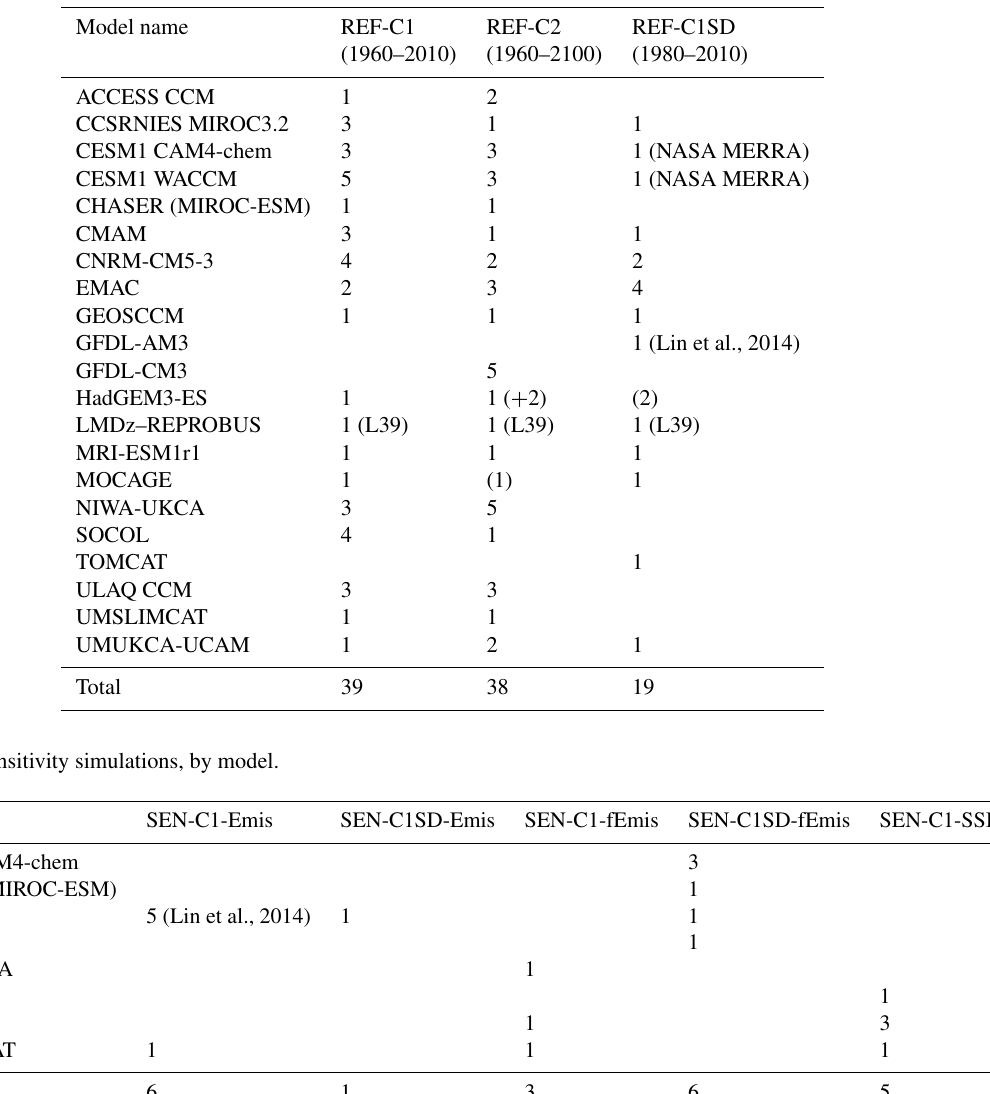
Table 4. Numbers of reference simulations, by model. Numbers in brackets denote simulations that are incomplete at the time of publication. “L39” stands for the 39-level version of LMDz–REPROBUS.